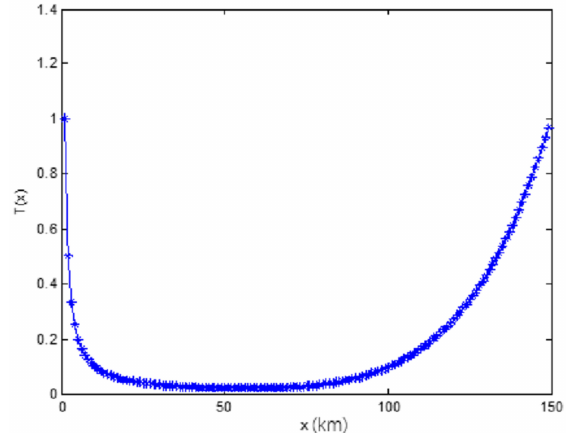
Figure 4. The plot of T ( x ) at Q = 150, n =